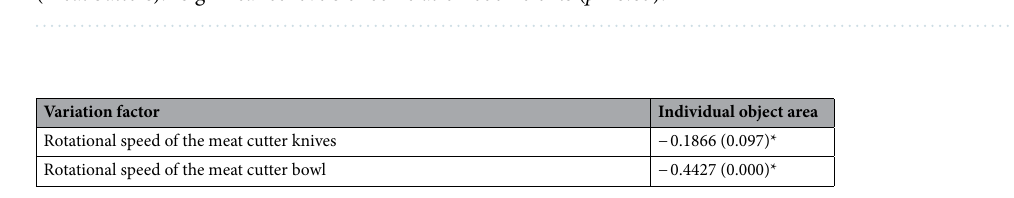
Table 5. The linear correlation between the area of individual objects and the variation factors under analysis (meat batters). *significance levels of correlation coefficients ( p ≤ 0.05).